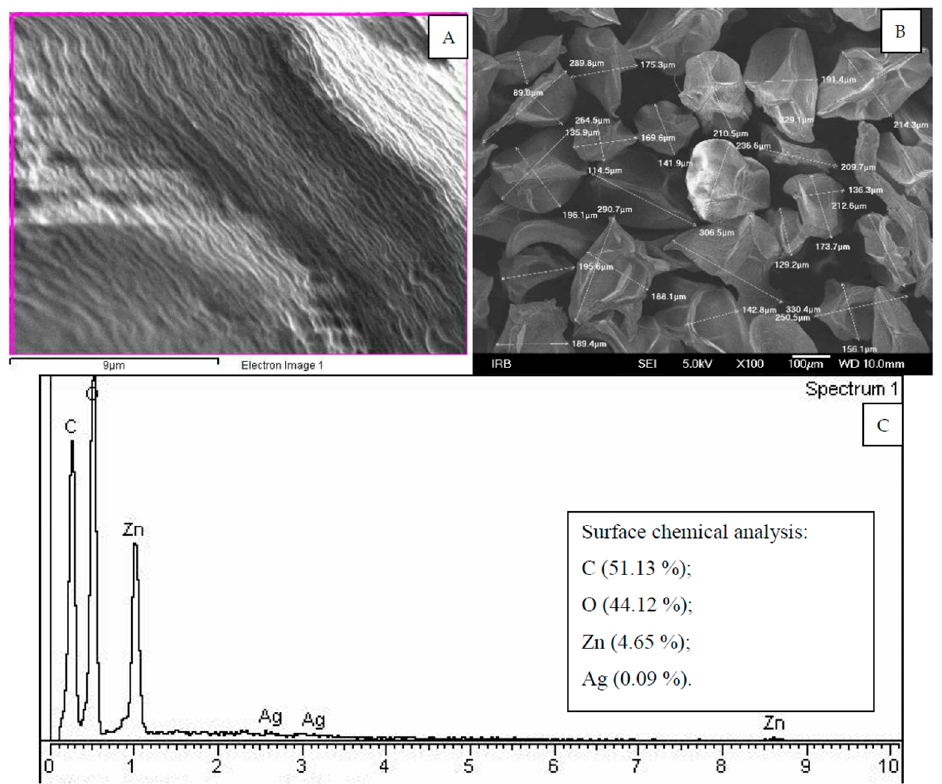
Figure 5. ( A ) SEM microphotograph of the surface of microcapsules, ( B ) determination of the morphological characteristics of the microcapsules, and ( C ) SEM-EDX spectra with the results of investigation of the surface of the microcapsules showing 0.09% of Ag and 4.65% of Zn.